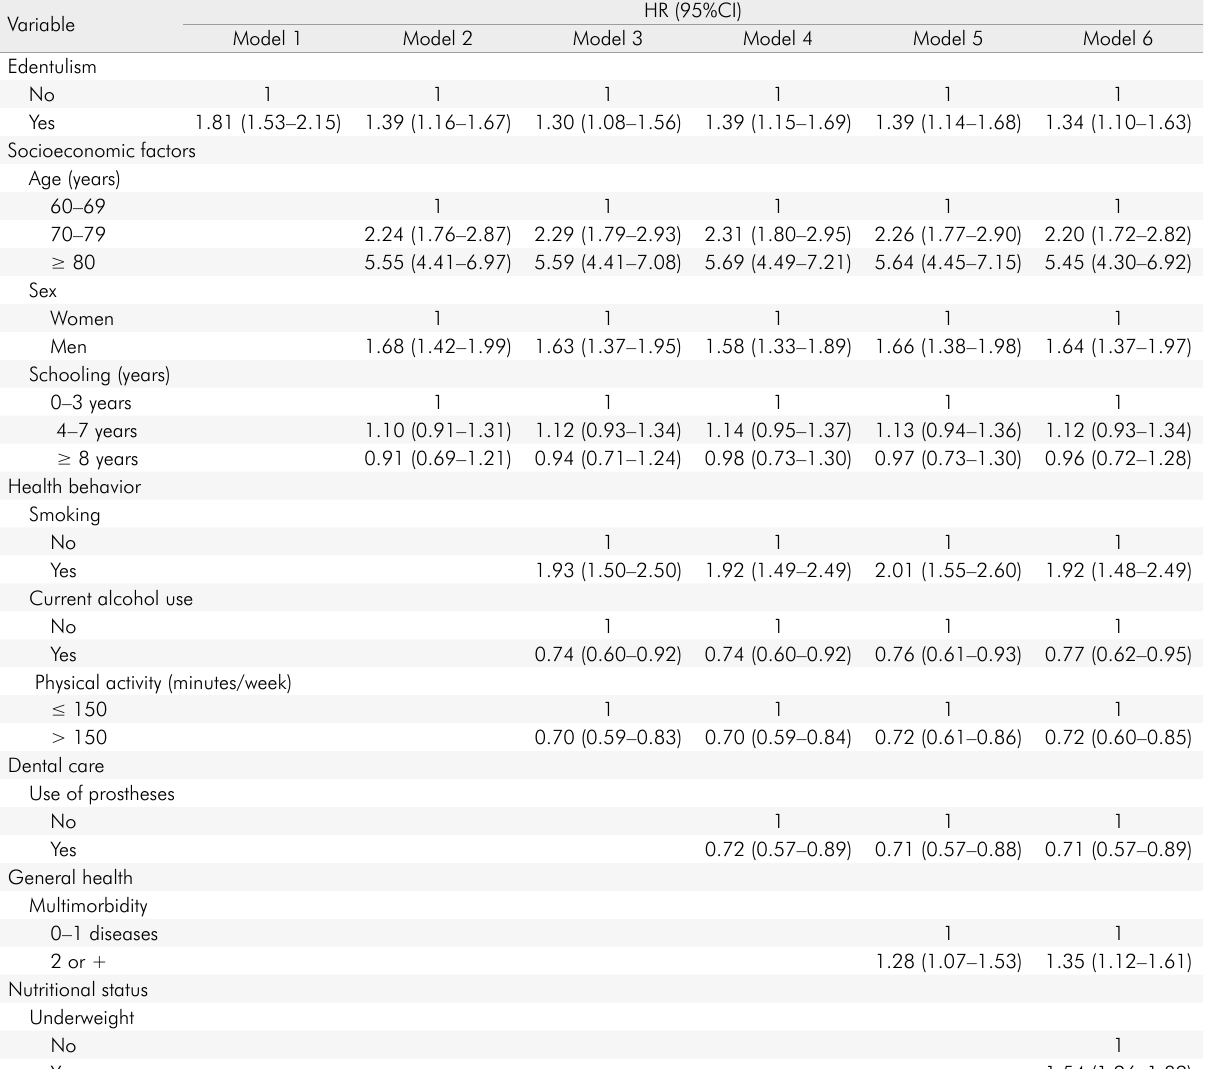
Table 2. Association between edentulism and all–cause mortality among Brazilian older adults.